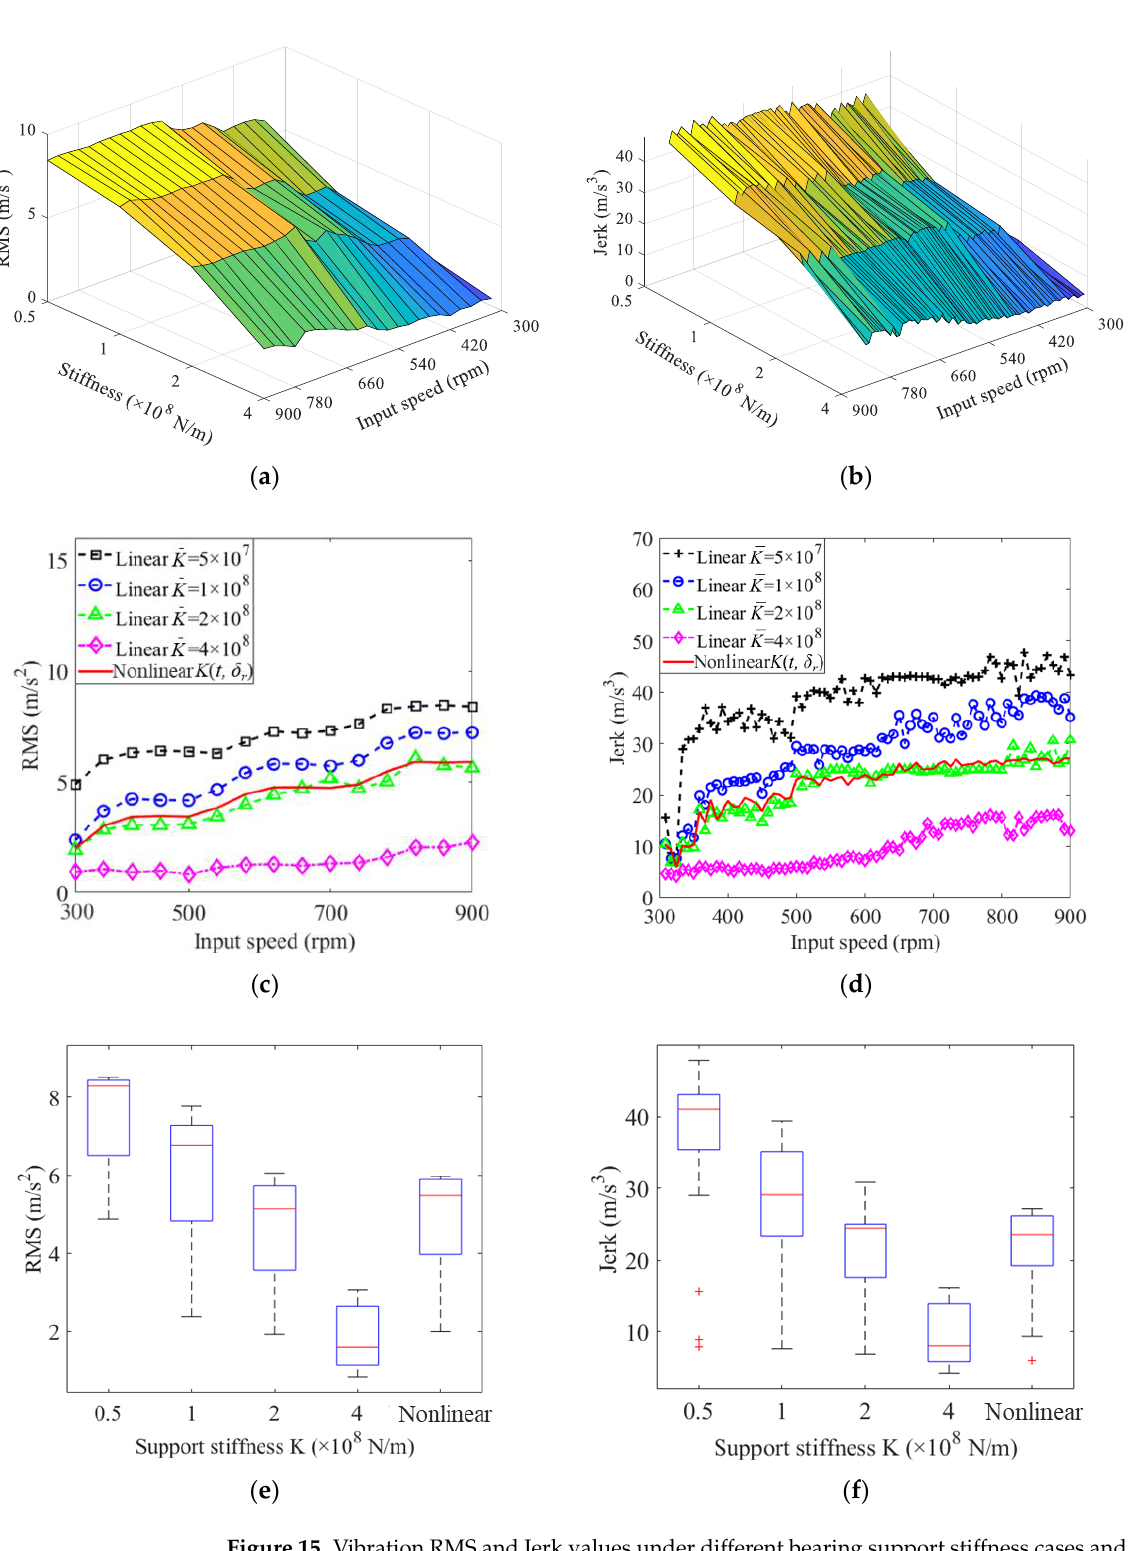
Figure 15. Vibration RMS and Jerk values under different bearing support stiffness cases and rotating speeds: ( a , c , e ) 3D view, front view, and boxplot of RMS; ( b , d , f ) 3D view, front view, and boxplot of the jerk.